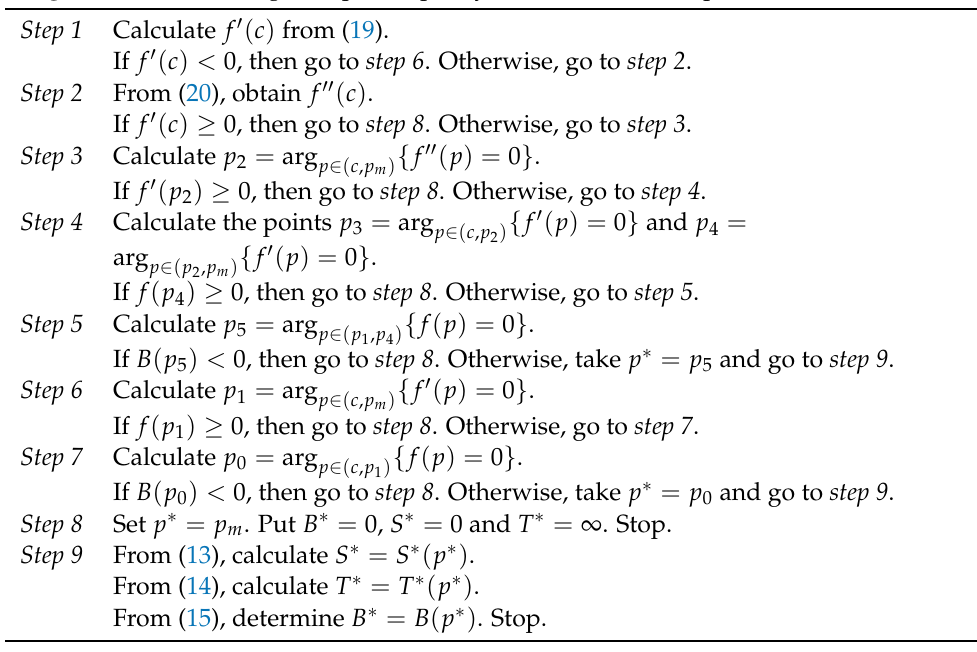
Algorithm 2 Obtaining the optimal policy and the maximum profit when 0 < γ < 1